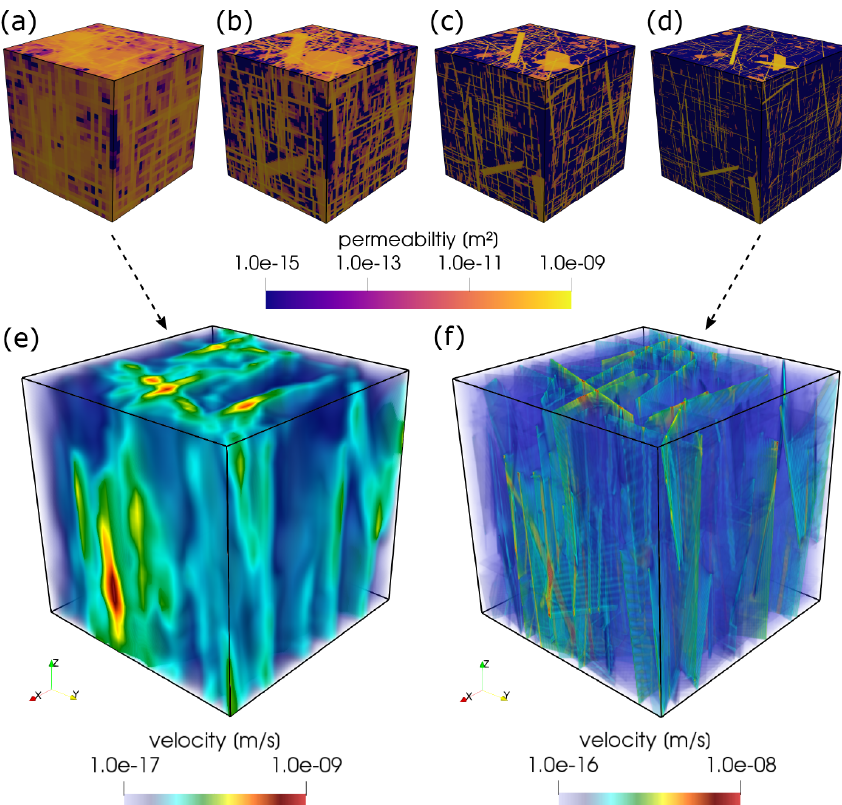
Figure 10. Panels (a–d) display the norm of the permeability tensor for each cell in an ECM representation of the 10000 fracture test DFNs displayed in Fig. 9 (a) for grid resolutions of 32 3 , 64 3 , 128 3 , and 256 3 voxels, respectively. Panels (e, f) visualize the resulting velocity distribution for an applied pressure gradient in the z